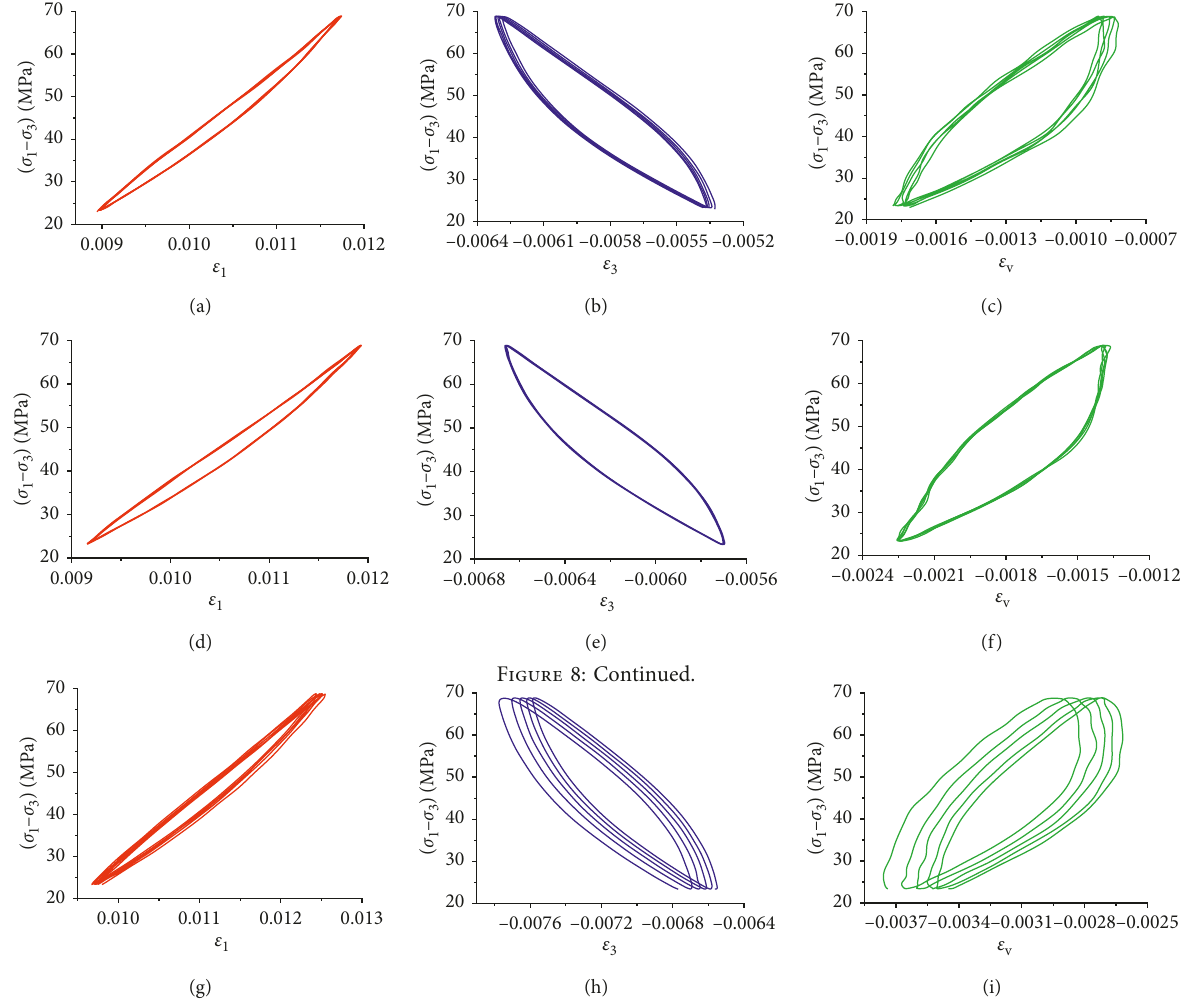
Figure 8: Comparison of deviatoric stress-strain hysteresis loops of limestone sample SA. 6 in different phases of fatigue failure at the failure stress level: (a) axial, (b) circumferential, and (c) volumetric hysteresis loops for cycles 2 to 6; (d) axial, (e) circumferential, and (f) volumetric hysteresis loops for cycles 199 to 203; and (g) axial, (h) circumferential, and (i) volumetric hysteresis loops for the last five cycles before failure.